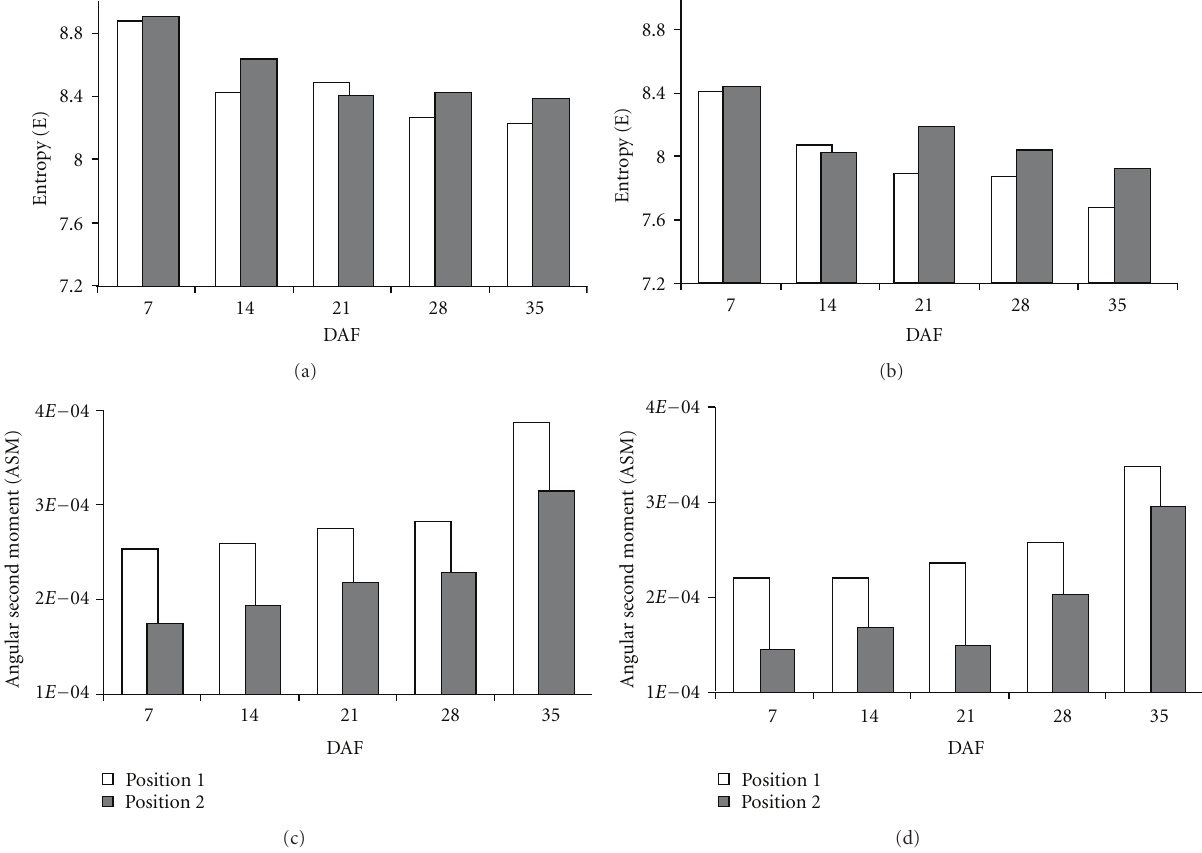
Figure 7: Textural parameters of electronic micrographs (2000X), corresponding to structure development of grain endosperm of rice Morelos A-98: (a,c) dorsal region and (b,d) ventral